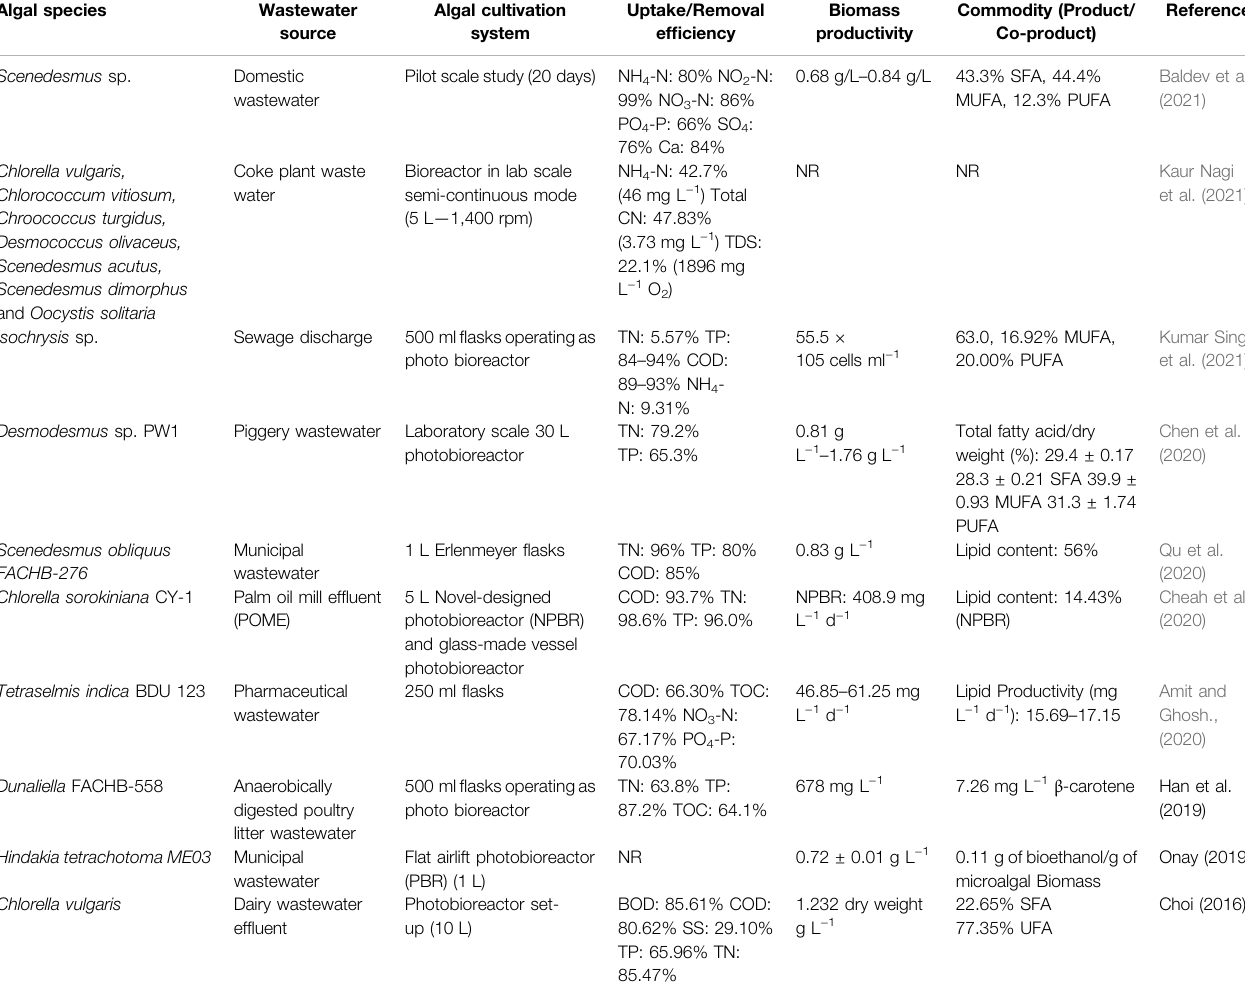
TABLE 2 | Microalgal nutrients removal ef fi ciency and biomass productivity in different wastewater treatment. Algal